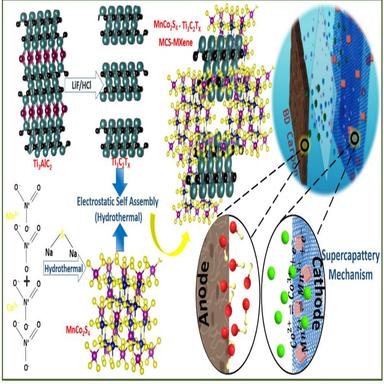
XRD patterns of (a) MAX phase and MXene; (b) MCS, MXene, MCS-MXene hybrid; (c) MCS, MCS-MXene (1:1), (1:2), (1:3) compositions; (d) Raman spectra of MAX, MXene, MCS, MCS-MXene (1:2).